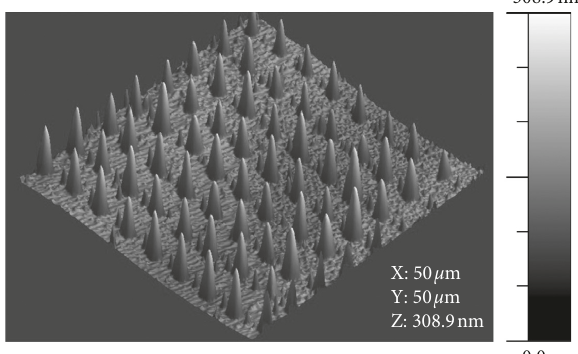
Figure 4: AFM image of pattern transference to